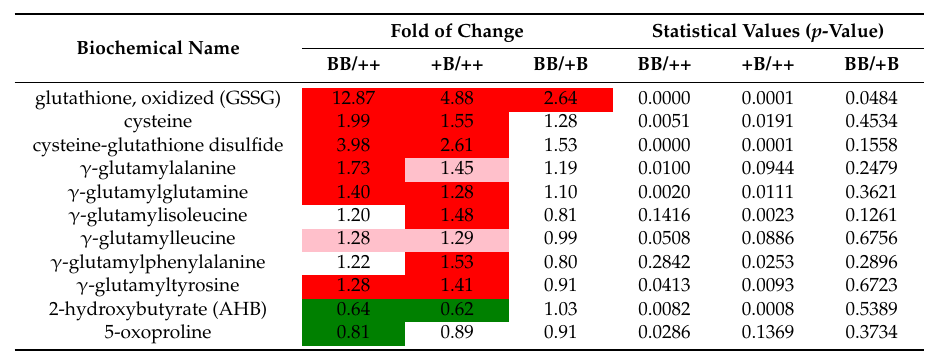
Red indicates significant difference ( p ≤ 0.05) between the groups shown and a metabolite ratio of ≥ 1.00; light red indicates a narrowly missed statistical cutoff for significance 0.05 < p ≤ 0.10 and a metabolite ratio of ≥ 1.00; green indicates a significant difference ( p ≤ 0.05) between the groups shown and a metabolite ratio of ≤